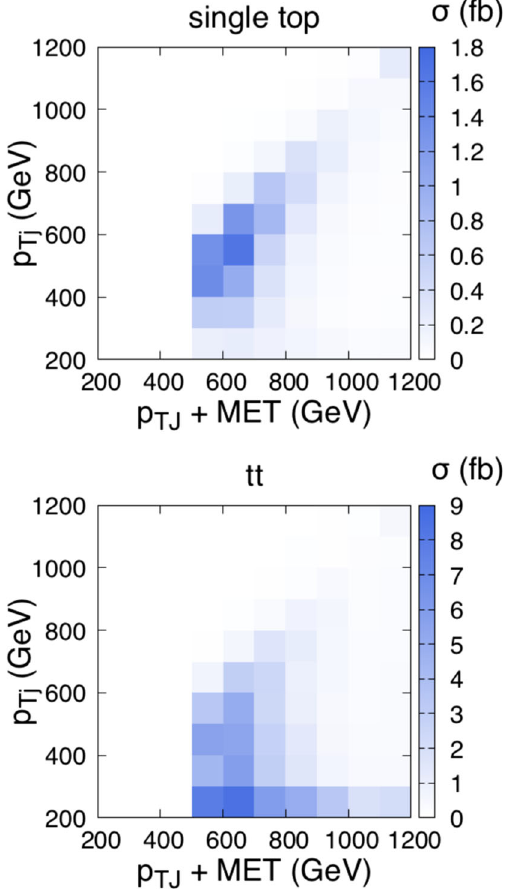
Fig. 4 Two-dimensional distributions of the sum of top jet p T plus missing transverse energy (MET) against the light jet p T for the single top signals (top) and the t ¯ t background, in the 1 b sample with the baseline selection